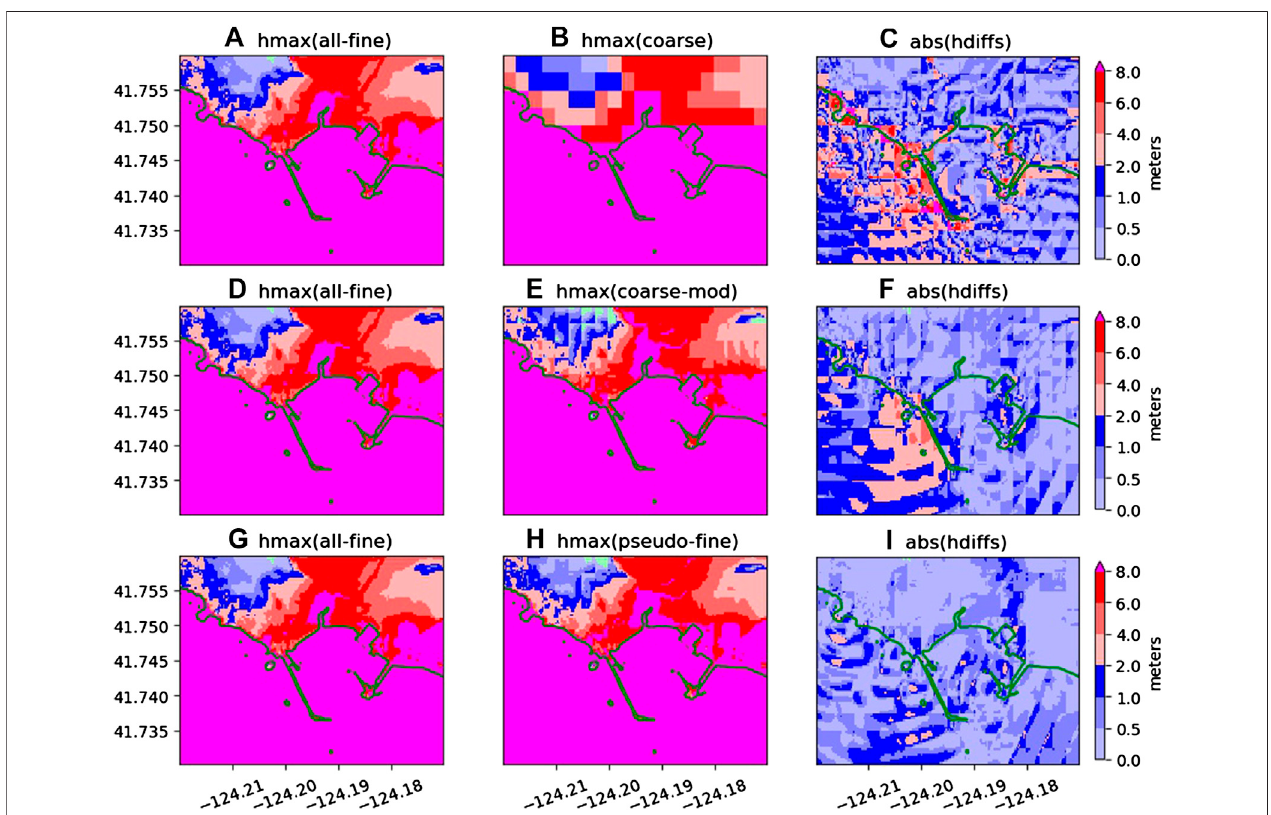
FIGURE6| Sampleresults forrealization 1,665at CrescentCity, wherethetsunami waslarge.Panels asdescribed in Figure5 .Purple isabove8 m. and Greenis land not inundated.